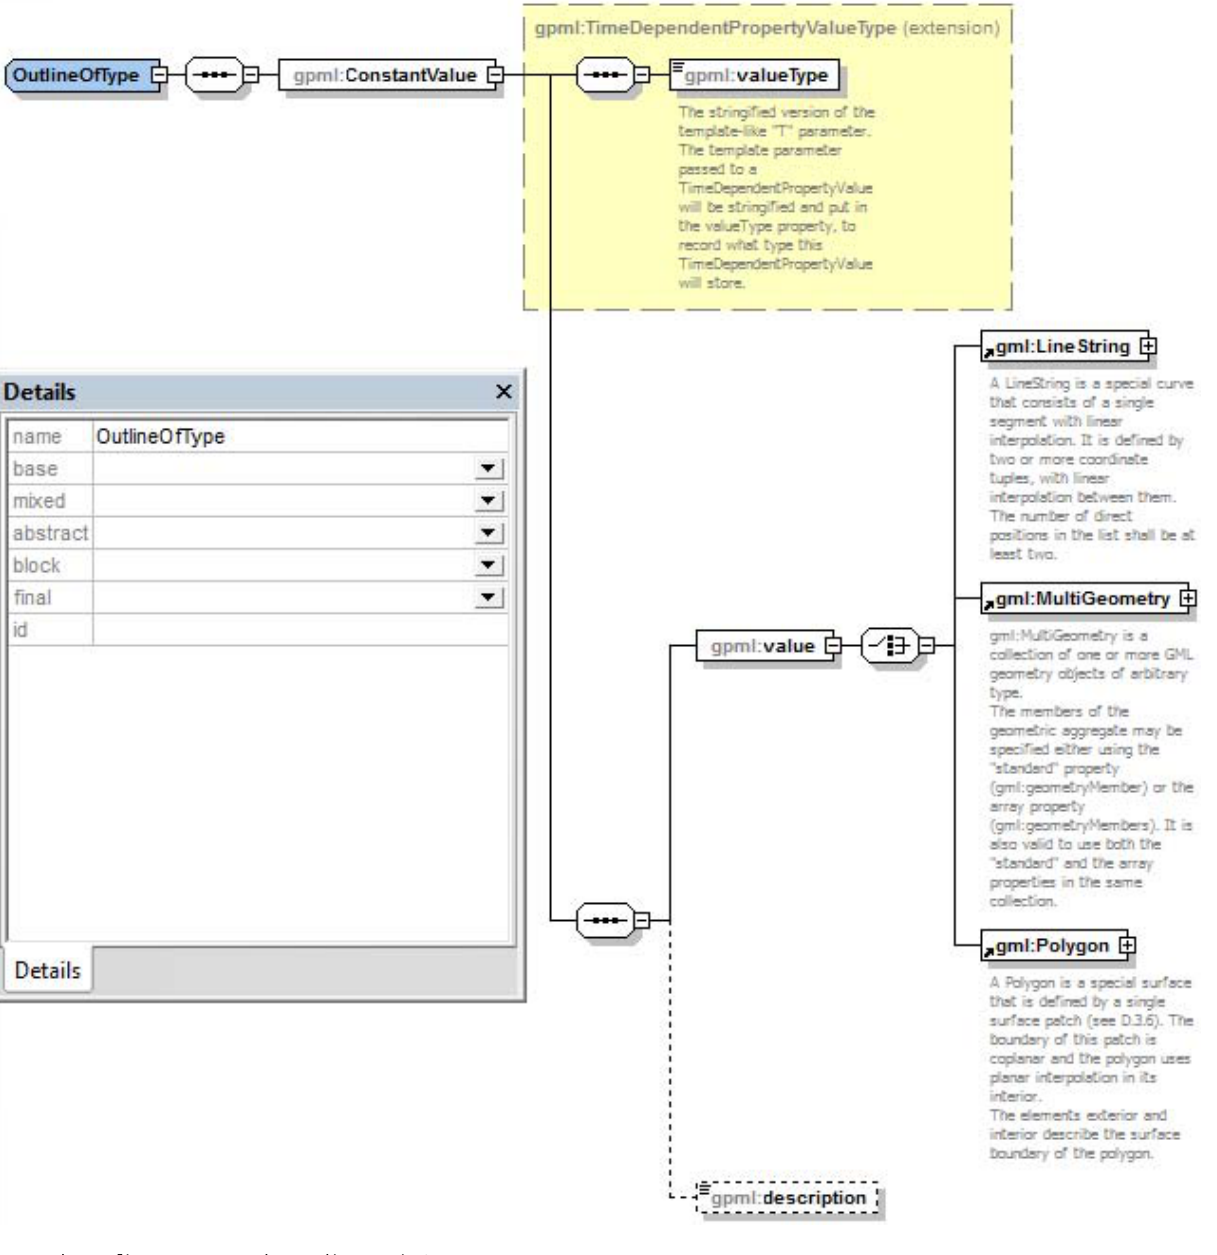
Fig. 17. The outline geometry schema diagram in